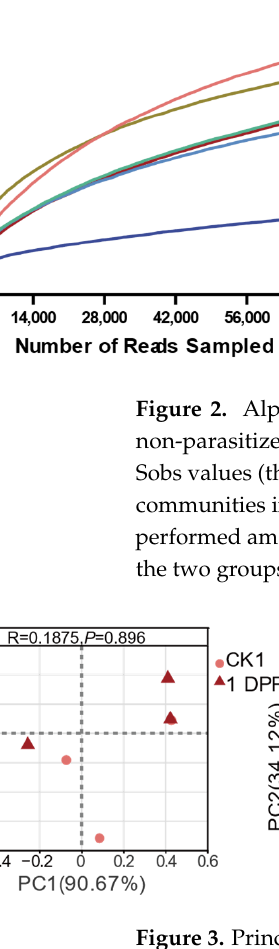
Figure 3. Principle coordinate analysis (PCoA) of the rarefied OTUs comparing the gut microbiota between parasitized and naïve control P. xylostella in different time categories with Bray-Curtis dissimilarity distance. ( a ) CK1 vs. 1 DPP, ( b ) CK3 vs. 3 DPP, ( c ) CK3 vs. 3 DPP. Analysis of similarities (ANOSIM) analyses revealed that the samples at 3 DPP were substantially different from those in the CK3 group ( p = 0.034).